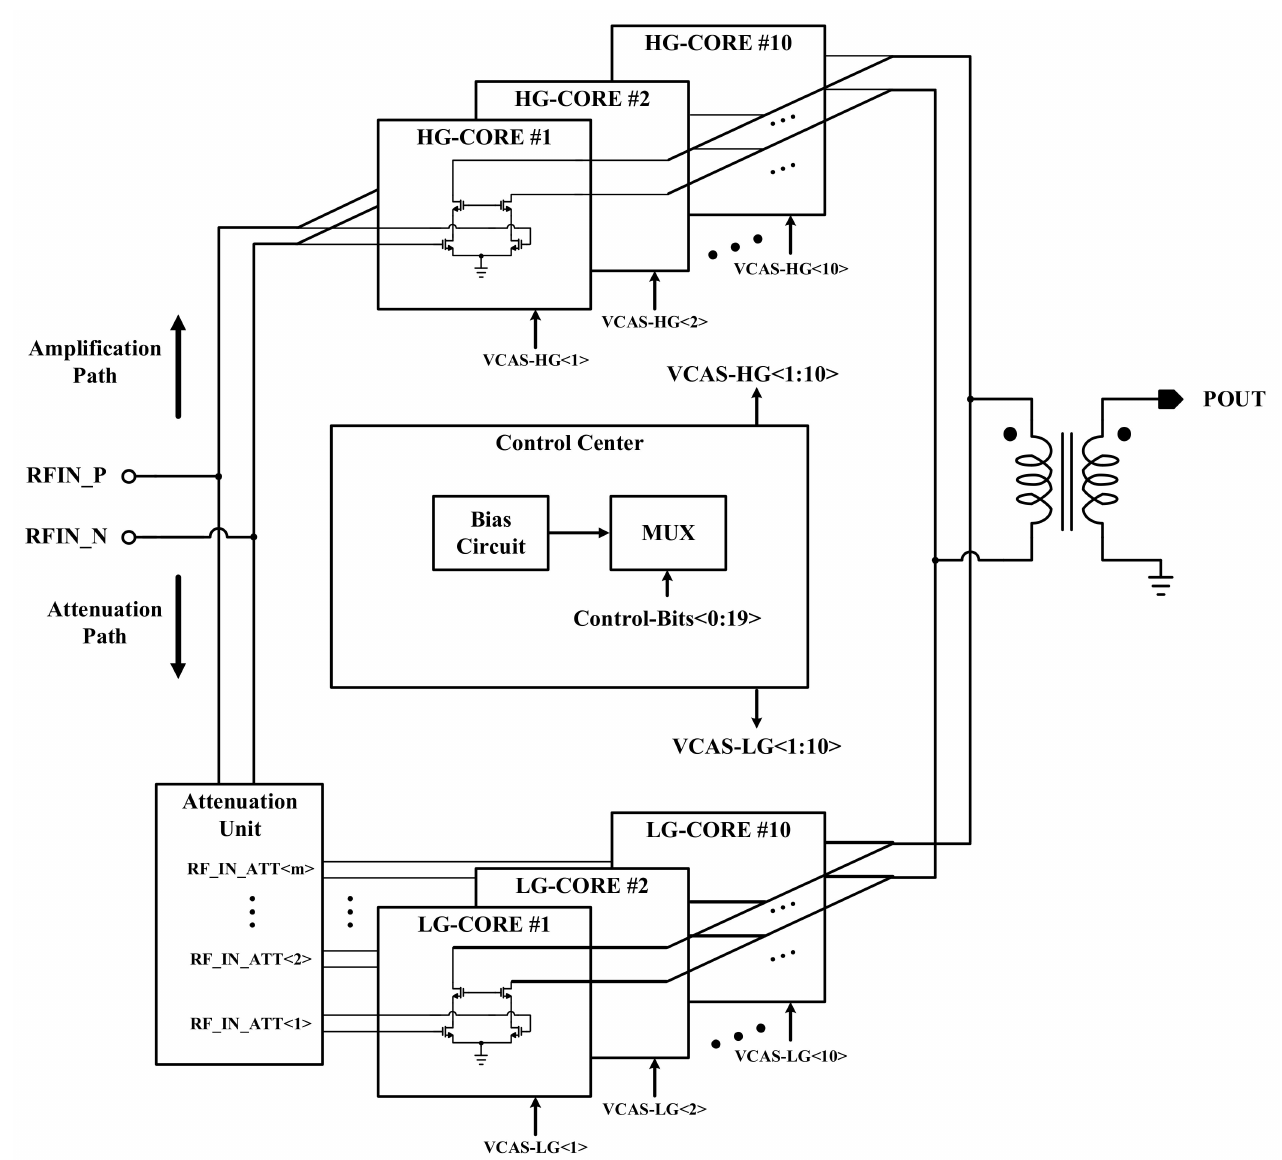
Figure 2. The proposed power combining DPA structure in a dual path of power amplification and attenuation